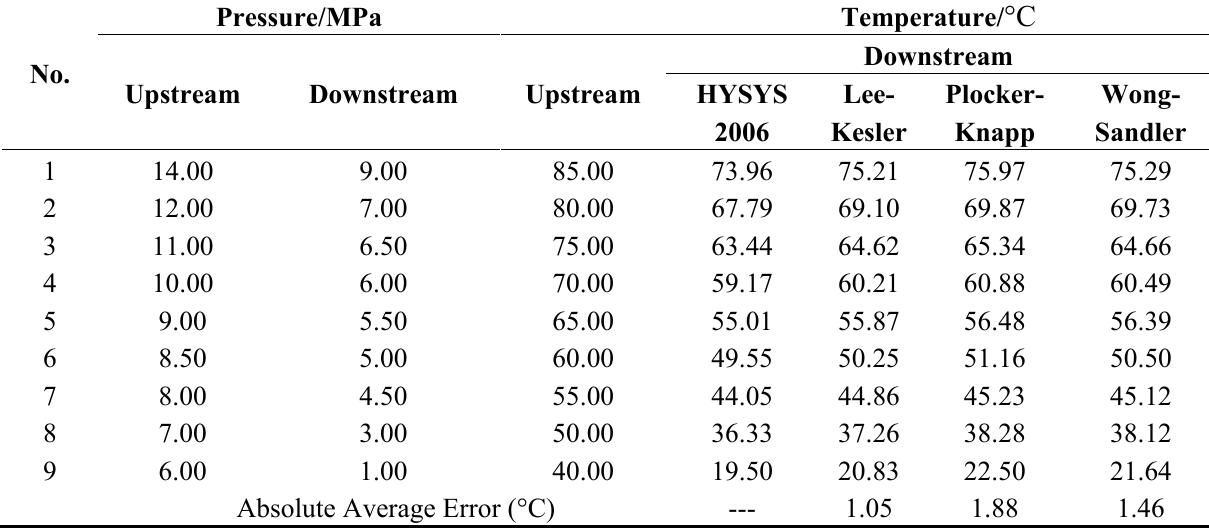
Table 2. Calculated downstream temperatures for DINA24 condensate gas.